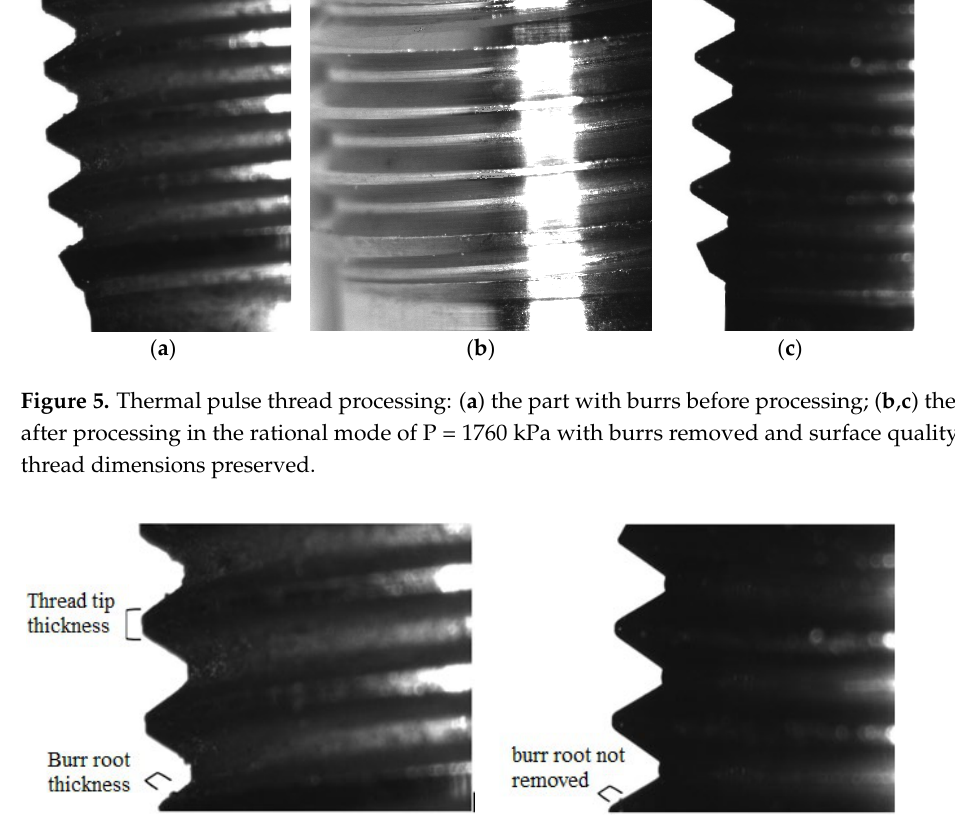
roughness decreases (Figures 7–10).